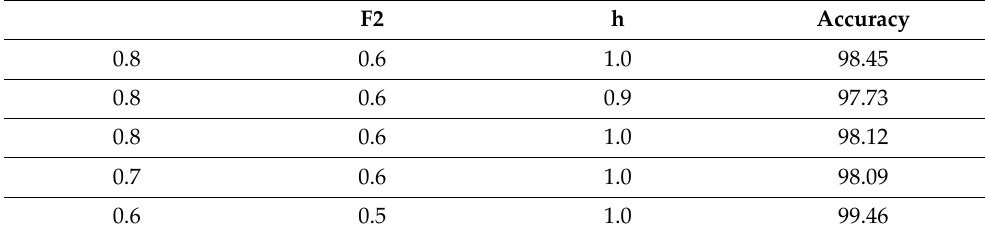
Table 10. Algorithm parameters for PSO using empirical data.